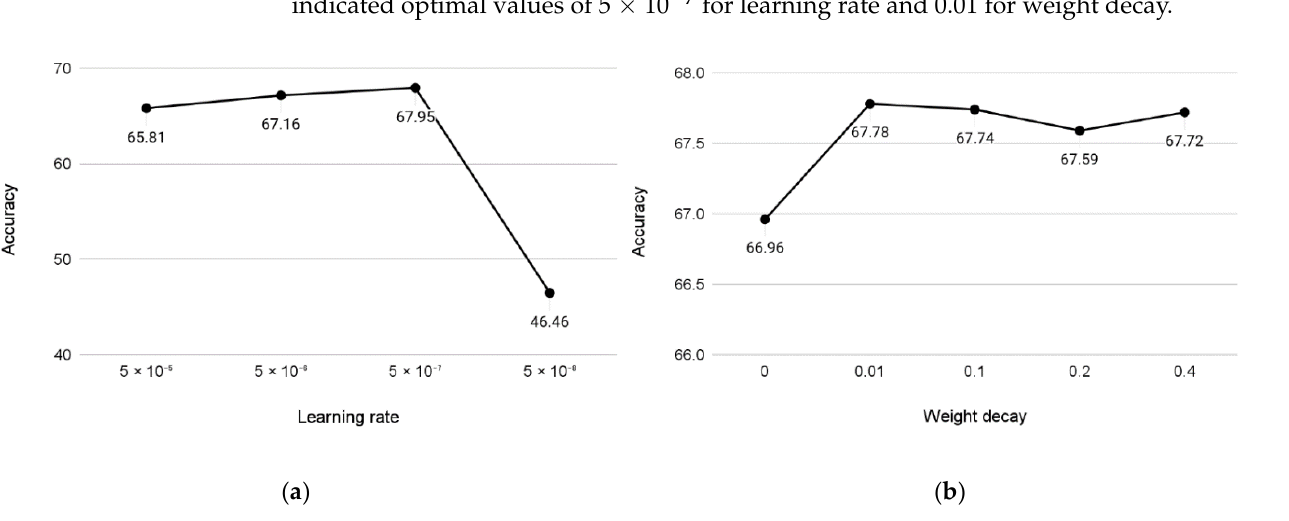
Figure 6. Sensitivity charts showing the changes in accuracy in relation to learning rate ( a ) and weight decay ( b ); training was conducted with the 6 + 1 category dataset version, limited to a maximum of 10 epochs.